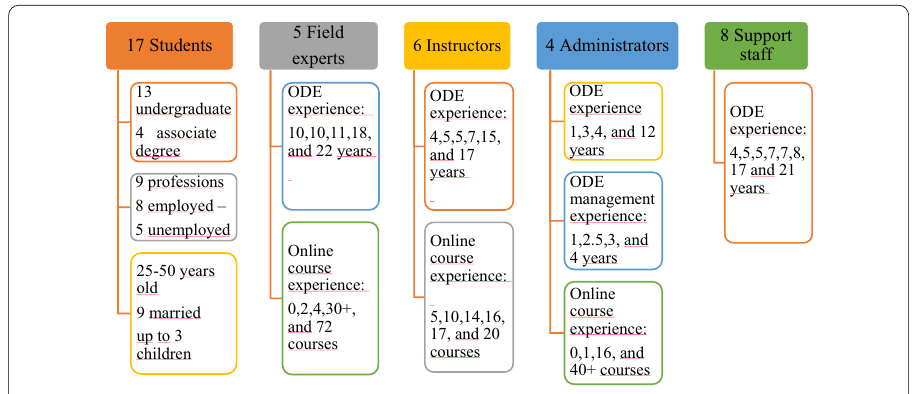
Fig. 1 Participant